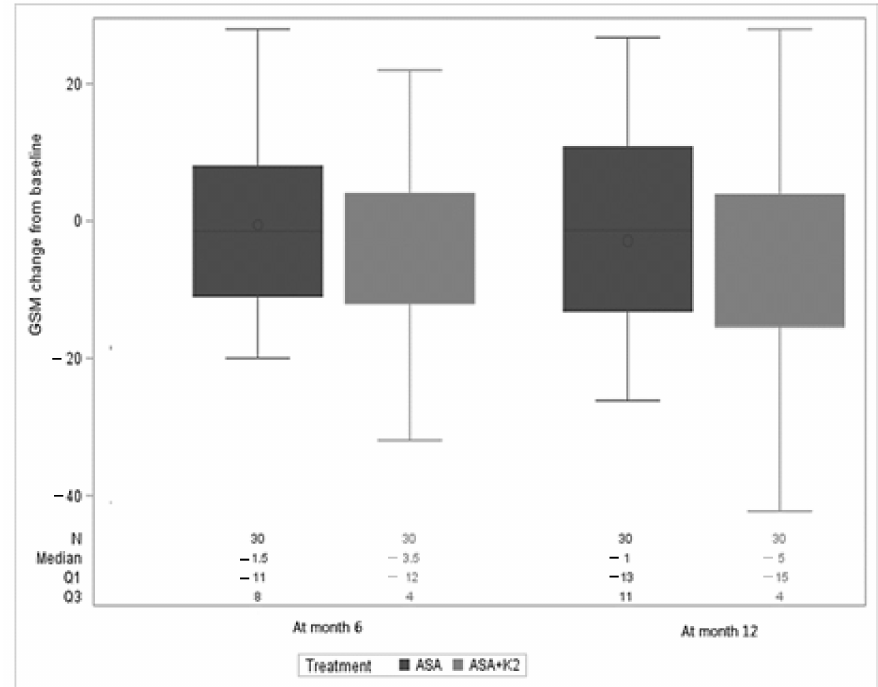
Figure 10. GSM change from baseline according to study arm. Patients with a GSM reduction of 15 points, compared to those without, tended to be older (71 (53–76) versus 61 (55–68) years; p = 0.075) with a higher baseline GSM (94 (82–113) versus 68 (53–96); p = 0.013) (Table 4). Patients with a GSM reduction of 7 points, compared to those without, had a higher baseline GSM (89 (67.5–103.5) versus change in GSM from baseline correlated significantly with higher baseline GSM ( p = 0.012 and p = 0.011, respectively). Use of antihypertensive drugs was also significantly